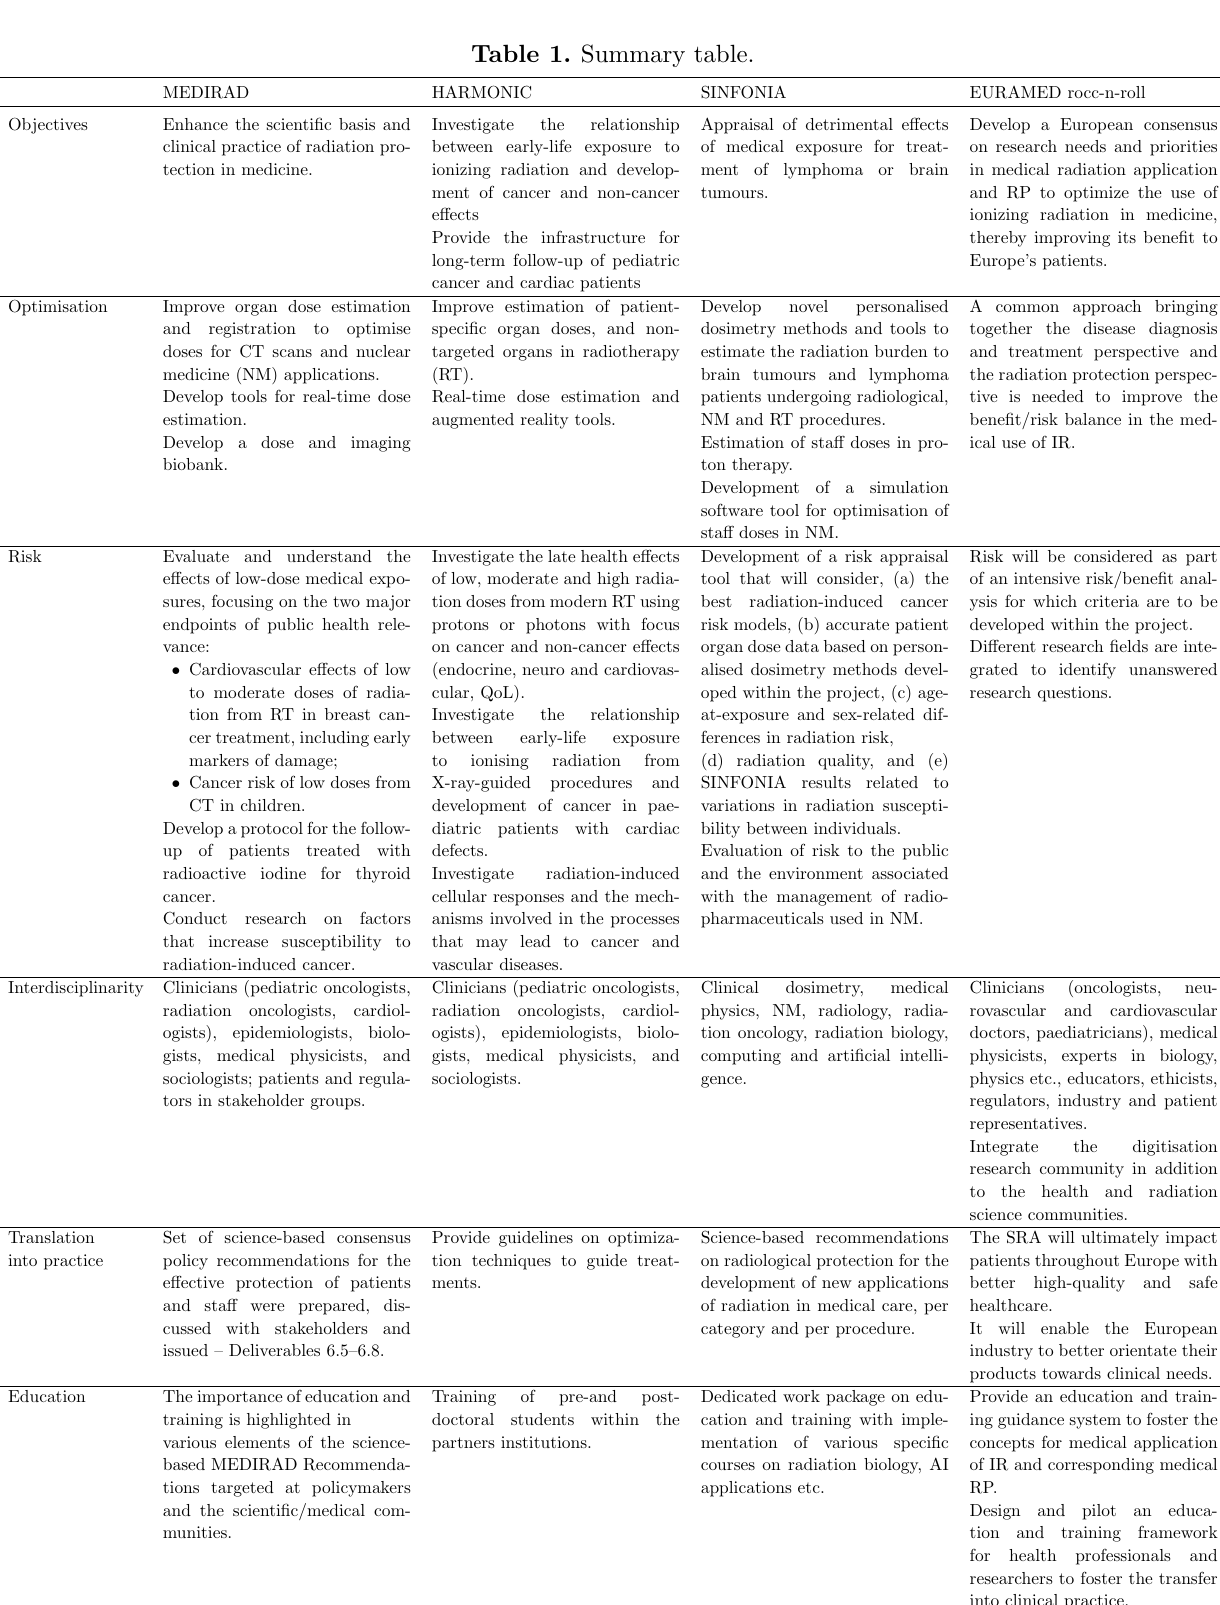
Table 1. Summary